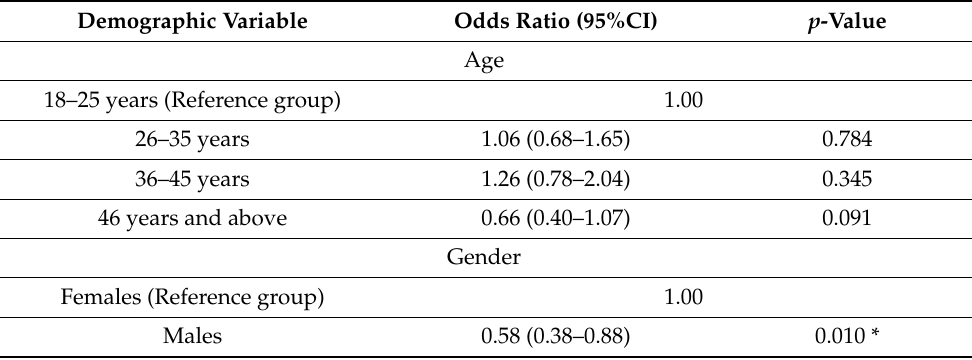
Table 4. Logistic regression